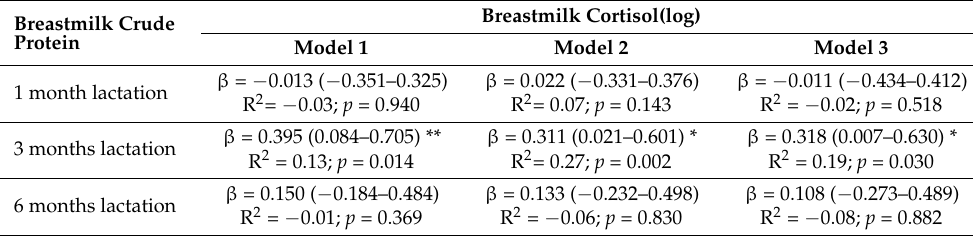
Table 4. Linear regression models between breastmilk cortisol(log) and breastmilk crude protein in the first sixth months